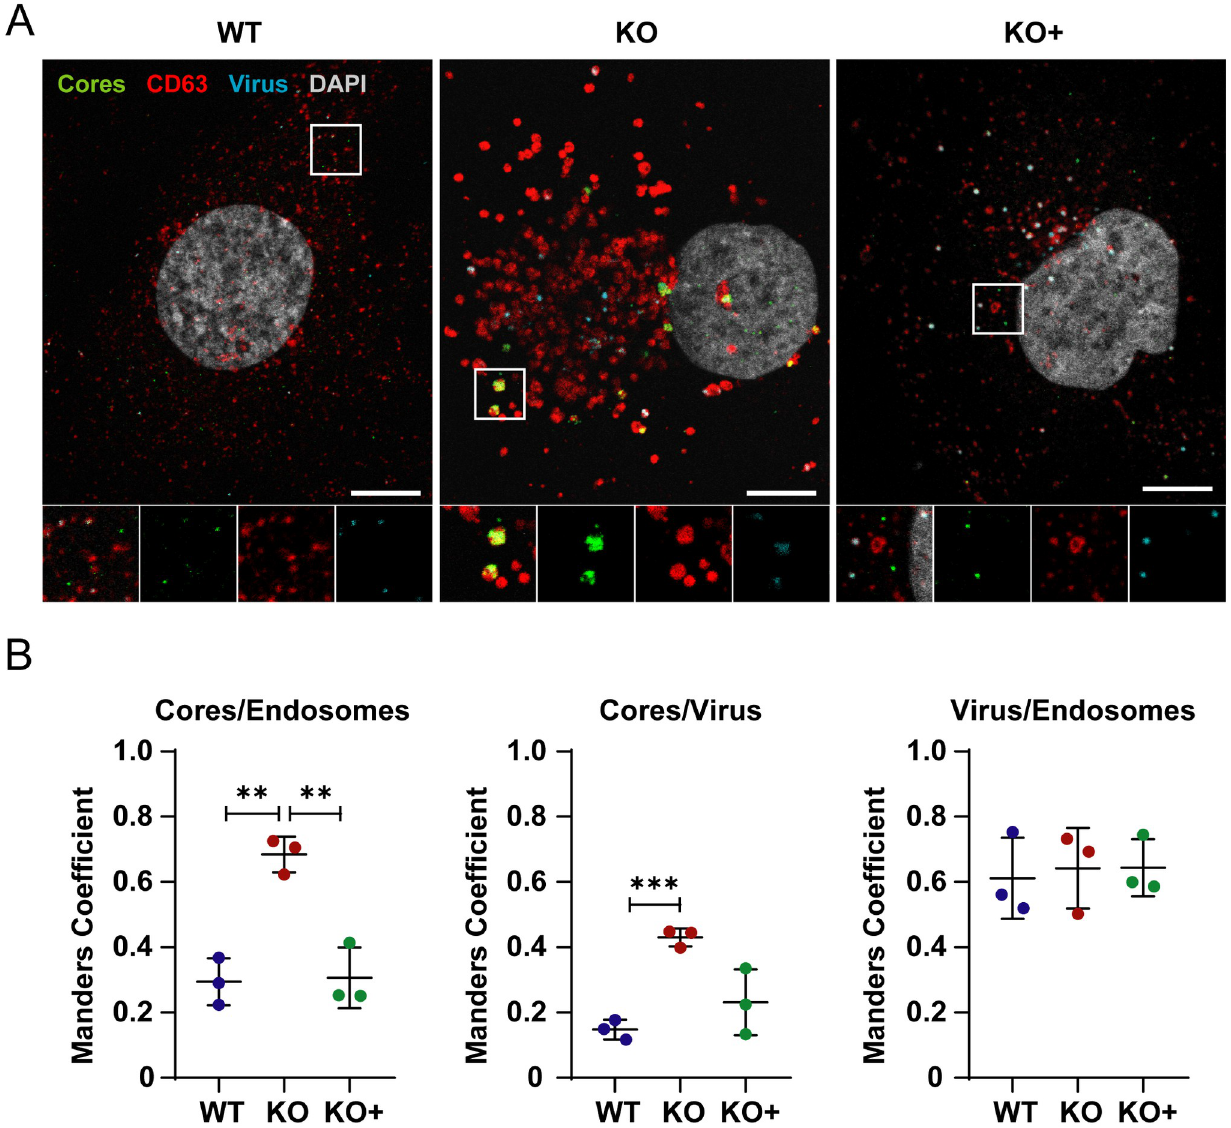
Fig 4. Cytosolic entry of reovirus cores. (A) WT, KO, and KO+ HBMECs were adsorbed with Alexa 647 labeled-reovirus virions (cyan) at an MOI of 10,000 particles/cell at 37˚C for 45 min and fixed with 4% PFA at 8 h post-adsorption. Cells were stained with DAPI (gray), a CD63-specific antibody to label endosomes (red), and an antiserum specific for reovirus cores (green), and imaged using confocal microscopy. Representative confocal micrographs are shown. Insets represent a merged image (far left), cores (center left), CD63 (center right), and virus (far right). (B) Colocalization of reovirus virions, cores, and endosomes was analyzed using the JaCoP plugin function from ImageJ. The results are presented as the mean colocalization (quantified by Manders coefficient) of * 50 cells from three independent experiments. Error bars indicate standard deviation. �� , P < 0.01; ��� , P < 0.001, as determined by two-tailed unpaired